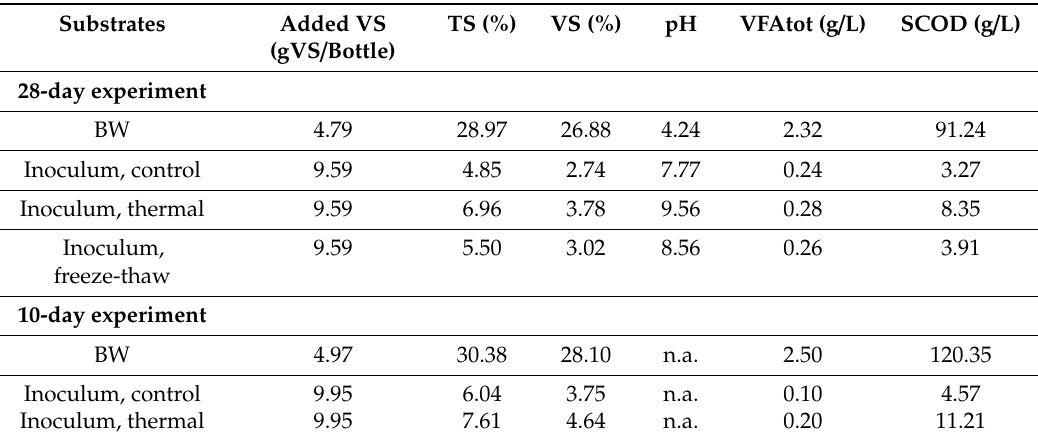
Table 1. Characteristics of BW and inocula used. Ten-day test results reported previously in [11]. Biowaste (BW), volatile solids (VS), total solids (TS), total volatile fatty acids (VFAtot), soluble chemical oxygen demand